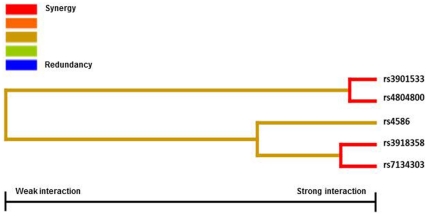
Interaction dendrogram generated by the MDR software.The interaction dendrogram was used to confirm, visualize, and interpret the interaction model. The MDR analysis was performed by using the open-source MDR software package. The colors used depict the degree of synergy, ranging from red (highest information gain) to blue (highest information redundancy). Note that the interaction between Dectin-1 (rs3901533) and DC-SIGN (rs4804800) SNPs showed the highest degree of synergy (gain of information).